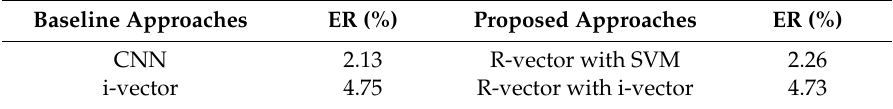
Table 5. Performance (Error Rate (ER)) of two-class LID experiments on SiTEC corpus. SVM: Support Vector